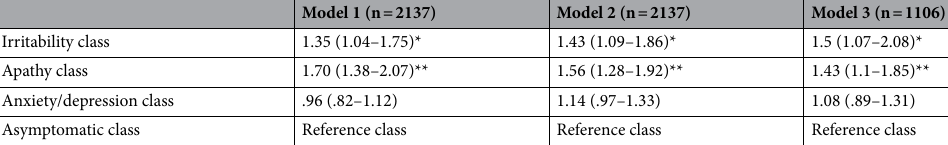
Table 4. Risk of conversion to dementia by 4 classes of preeminent neuropsychiatric symptoms applying three different models (Cox proportional hazards). Values are hazard ratios (CI 95%). Model 2 = Adjusted by class group, age, gender, MMSE score, and years of education. Model 3 = Adjusted by class group, age, gender, MMSE score, years of education and APOE- Ɛ 4. * p < .05; ** p < .001; Model 1 = Adjusted by class